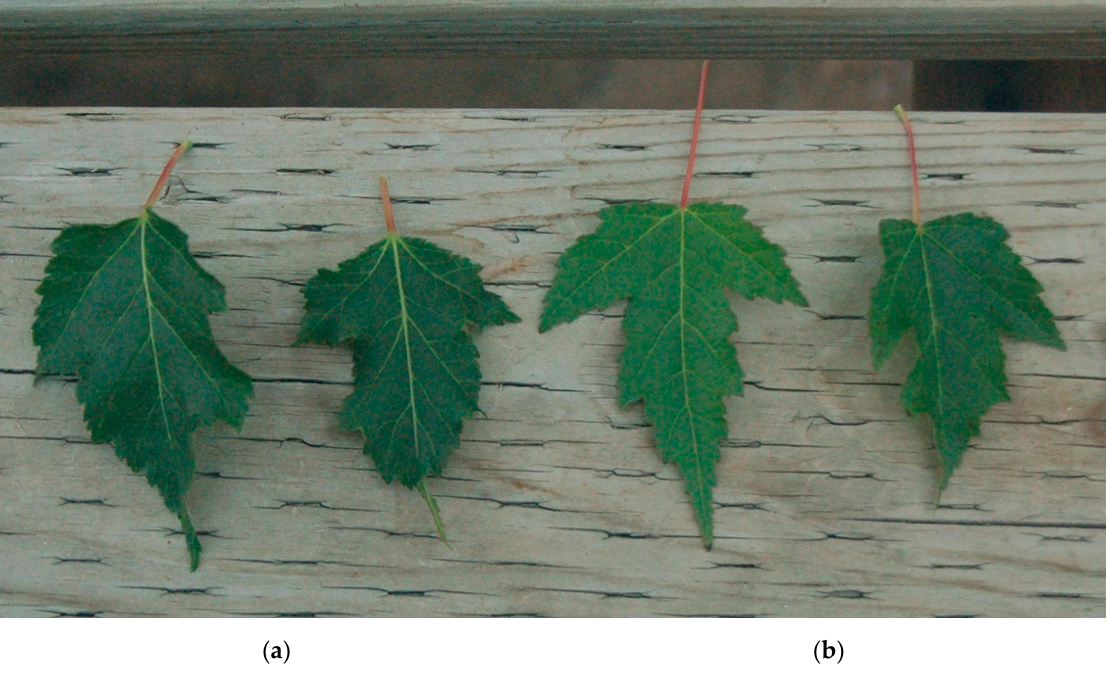
Table 4. Ploidy of seedlings of Acer buergerianum (trident maple) and A. tataricum ssp. ginnala (Amur maple) treated during 2012, for 5 d with 25 μ L of 150 μ M oryzalin supplied as Surflan + 0.55% agar applied to meristems at the first true leaf stage.